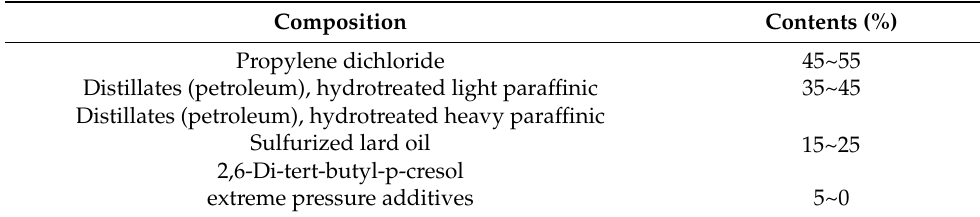
Table 2. Chemical composition of oil particles used in the experiment .